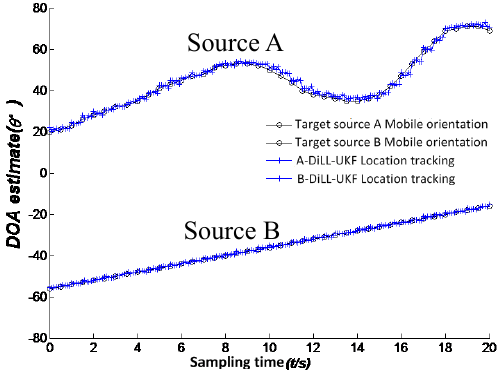
Figure 7. Location and tracking of 2 targets by